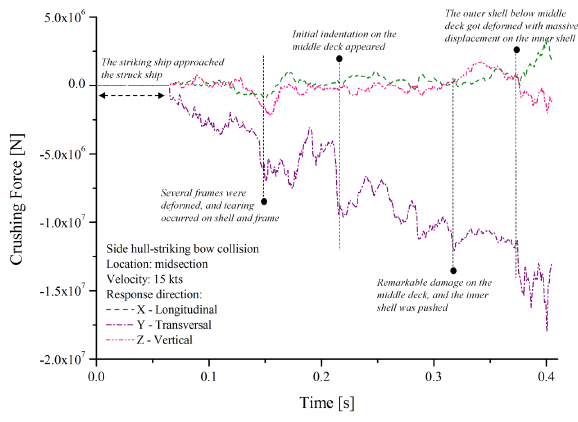
Figure 7: Patterns of crushing force, and sequences of progressive failure: after-end impacted by velocity 15 kts.